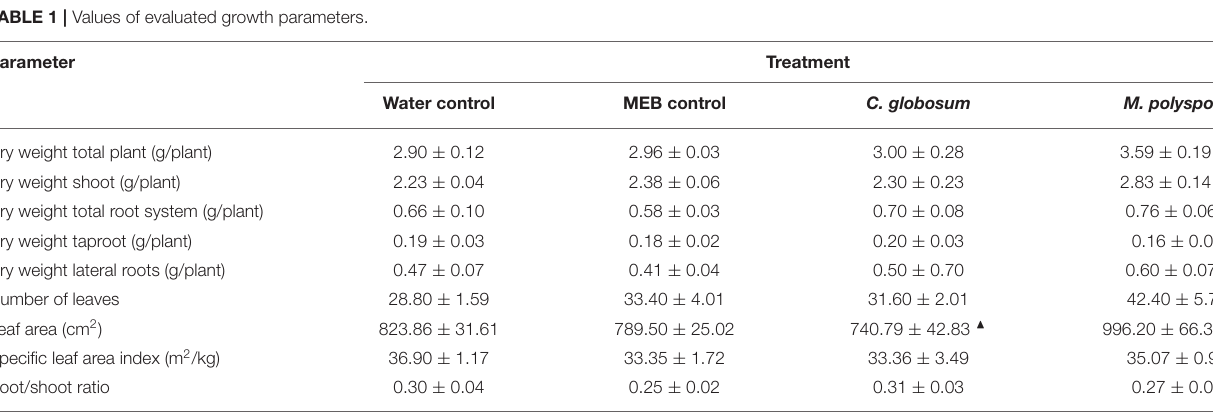
TABLE 1 | Values of evaluated growth